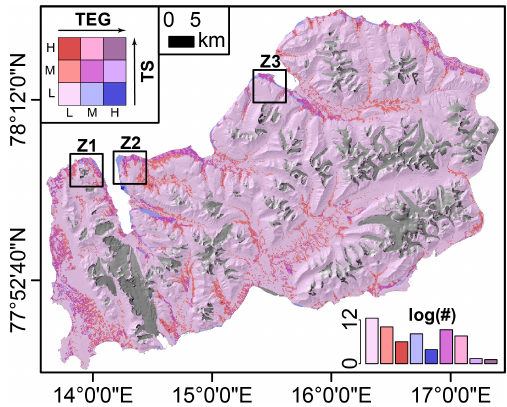
Figure 8. Multi-hazard susceptibility map of TSs and TEGs for Nordenskiöld Land. The bar plot at the bottom right represents the number of grid cells expressed in logarithmic scale for each of the nine combined susceptibility